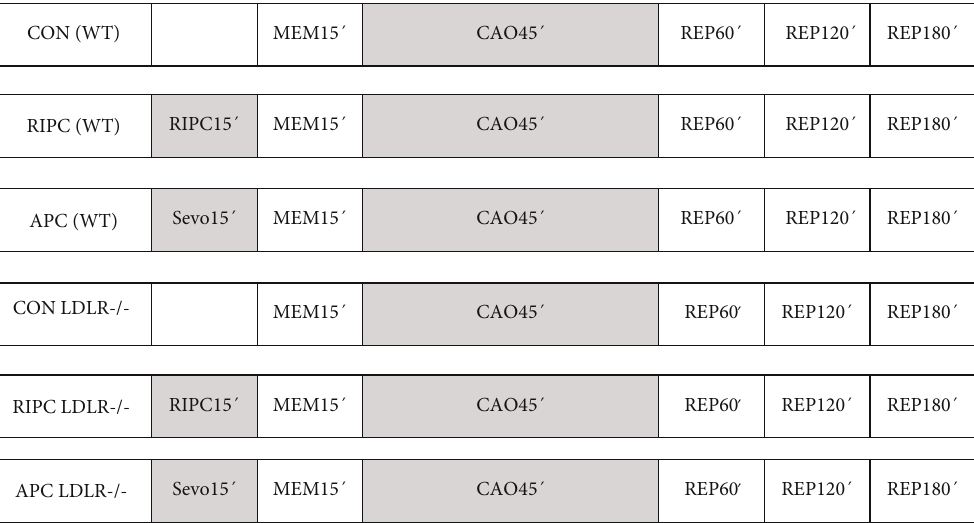
Figure 1: Study protocol and time line. CON WT: control group (C57/BL6 wild type) no preconditioning; MEM15 ′ : memory phase over 15 minutes; CAO45 ′ : coronary artery occlusion over 45 minutes; REP60 ′ , 120 ′ , and 180 ′ : reperfusion phase 60, 120, and 180 minutes after COA45 ′ ; RIPC WT: remote ischemic preconditioning group (C57/BL6 WT); APC WT: anesthetic-induced preconditioning group (C57/BL6 wild type); CON LDLR-/-: control group (C57/BL6 LDL-receptor de fi ciency); RIPC LDLR-/-: remote ischemic preconditioning group (C57/BL6 LDL-receptor de fi ciency); APC LDLR-/-: anesthetic induce preconditioning group (C57/BL6 LDL-receptor de fi ciency). At the end of REP180 ′ , the mouse was sacri fi ced and the heart was isolated.